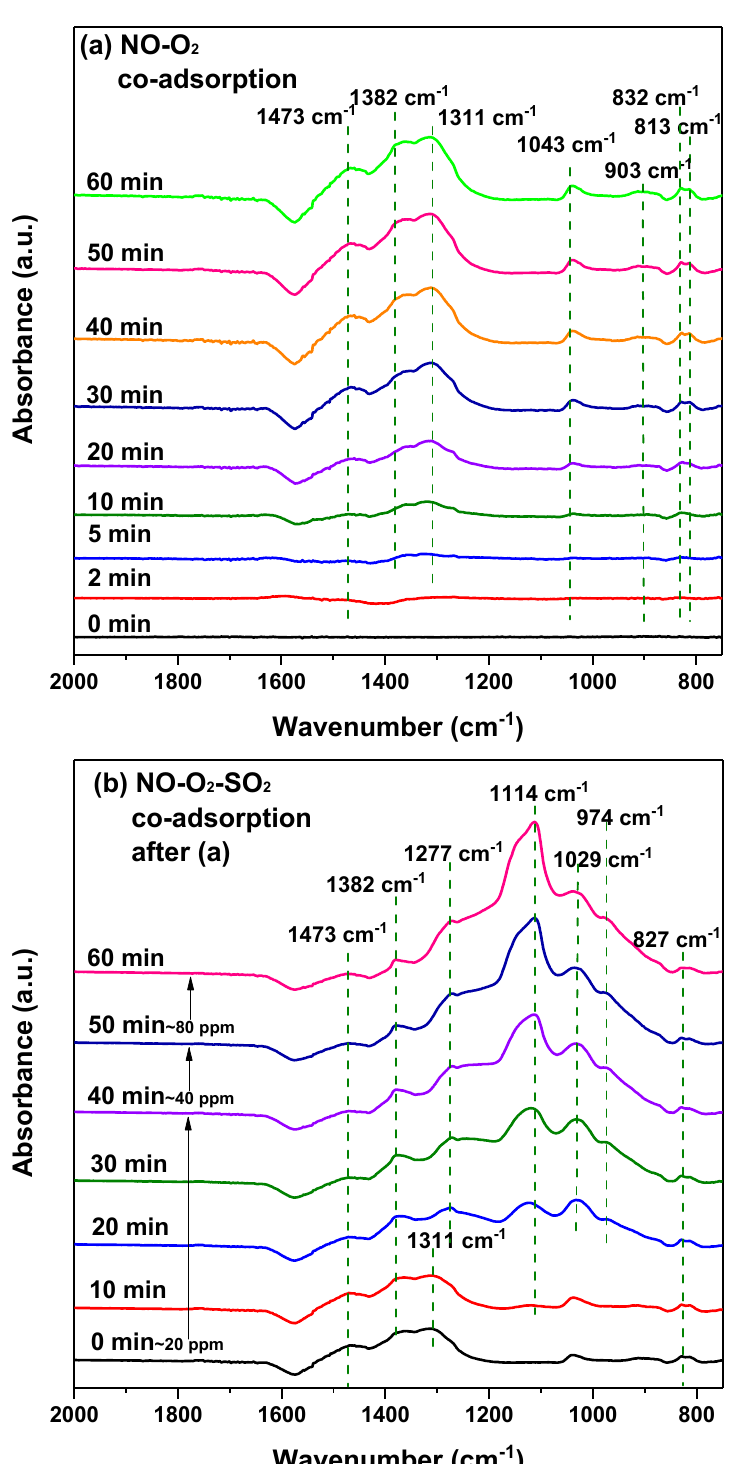
Figure 8. In-situ DRIFTS spectra of MnCe during NO–O 2 co-adsorption (( a ) 200 ppm NO–10% O 2 , N 2 balance and ( b ) 20~40~80 ppm SO 2 addition).